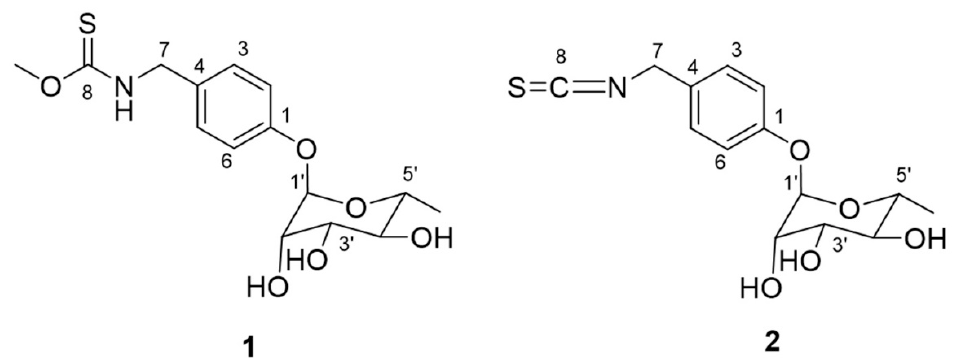
Figure 3. Chemical structures of 1 (niazinin B) and 2 (4-[( α -L-rhamnosyloxy)benzyl]isothiocyanate).